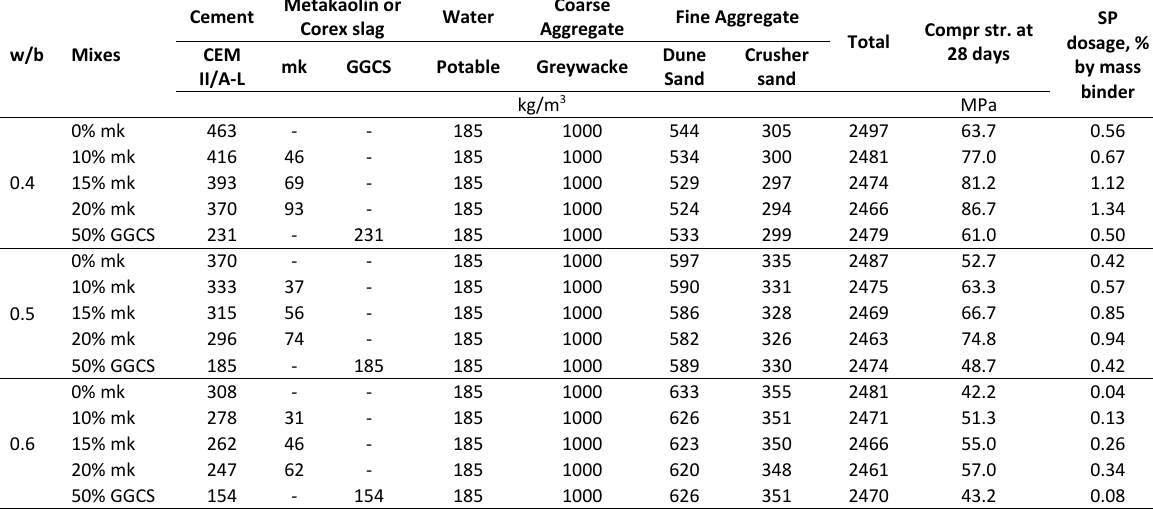
Table 3. Concrete mix proportions – kg/m 3